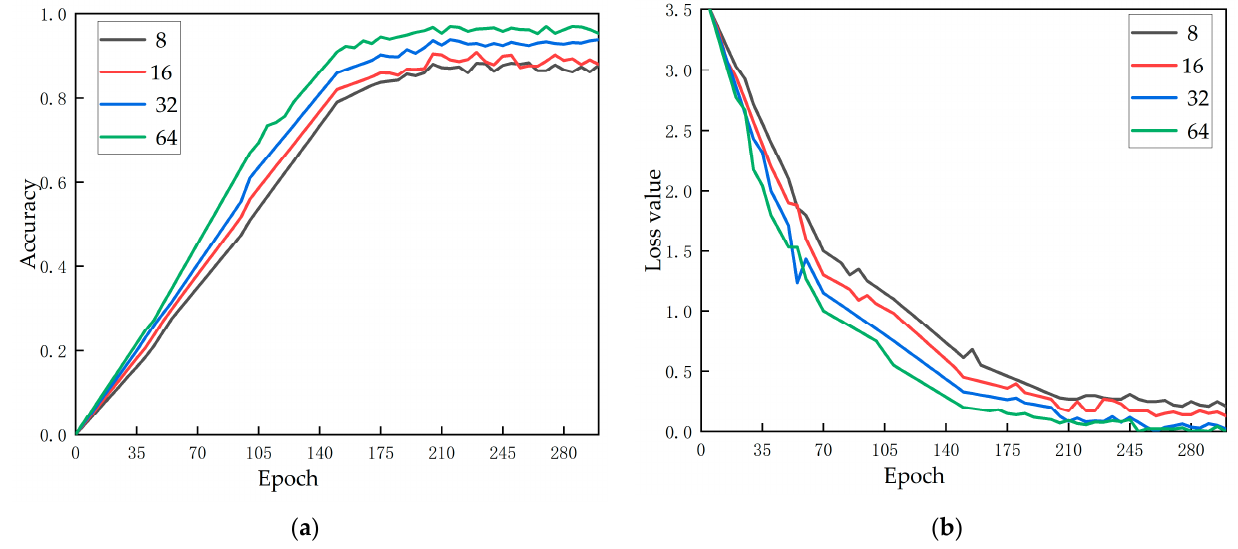
Figure 8. ( a ) Effect of the batch size on accuracy; ( b ) Effect of the batch size on loss.